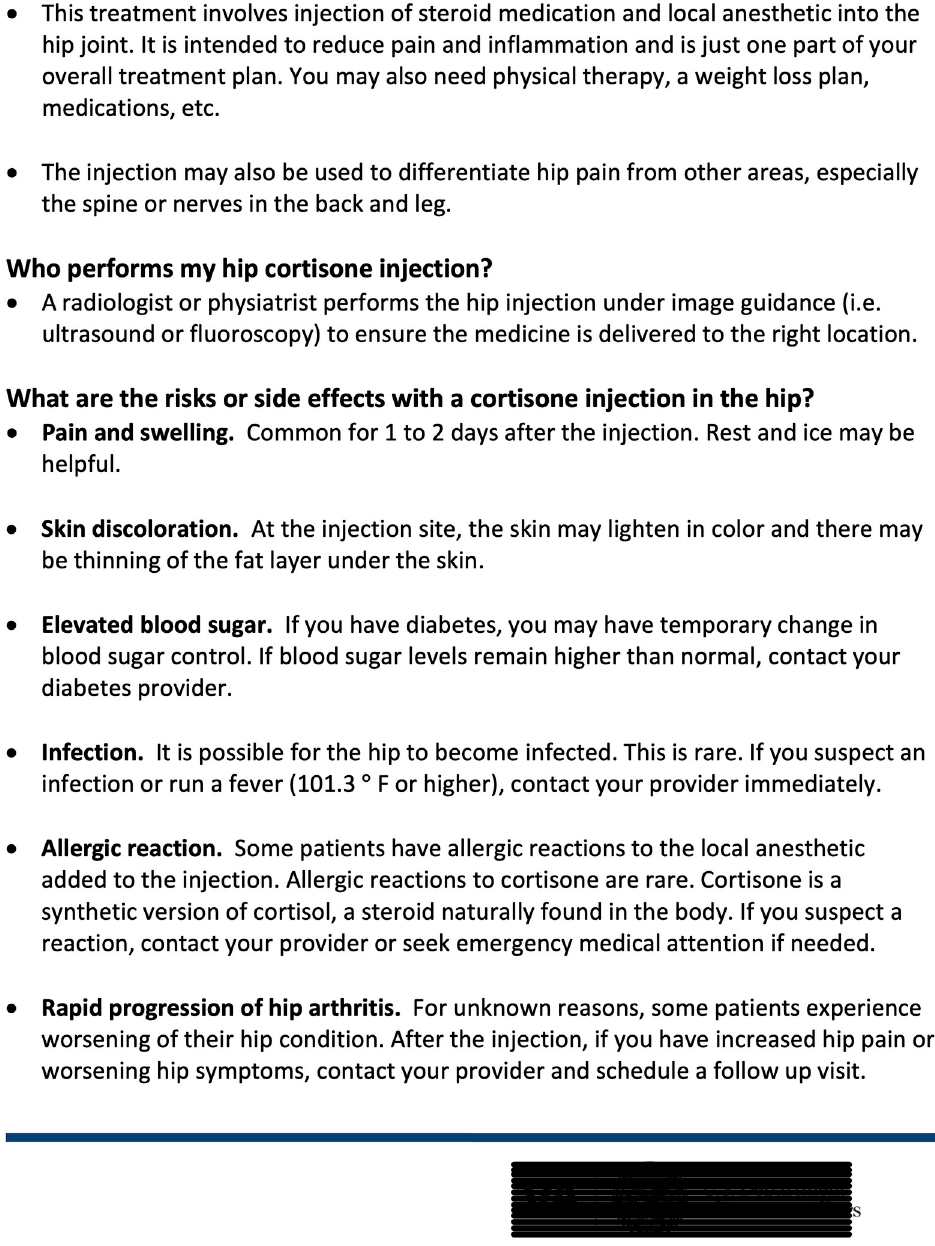
Fig 3. Procedure-specific education material available for all patients and providers at our institution.